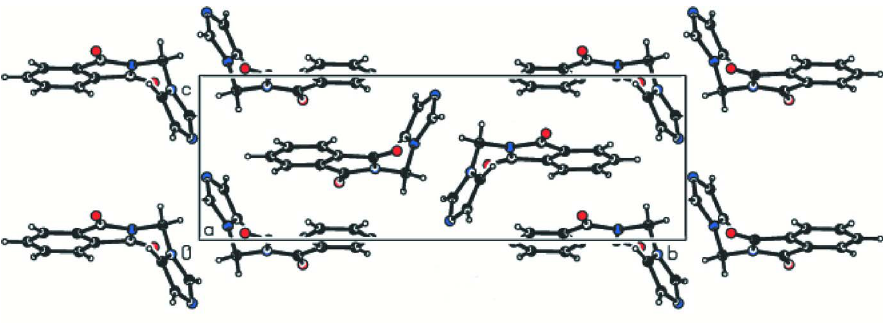
Figure 1 The molecular structure and atom-labeling scheme for (I), with displacement ellipsoids drawn at the 50% probability level.